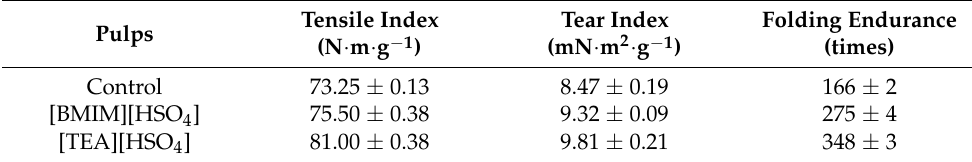
Table 4. The effect of IL pretreatment on the physical strength of oxygen-bleached